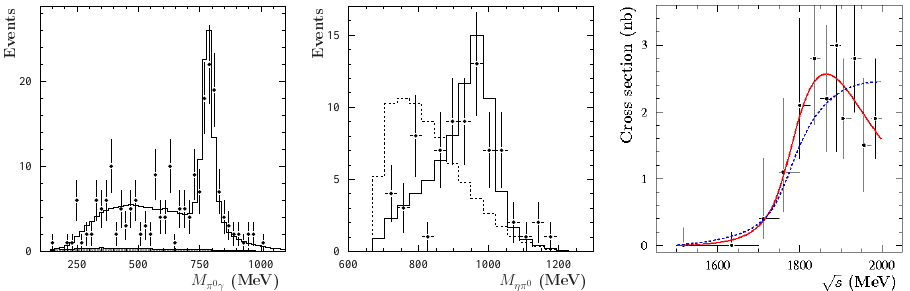
Figure 6. Left panel : The π 0 γ invariant mass spectrum which shows the dominance of the ωπ 0 η intermediate state. Middle panel : The ηπ 0 invariant mass spectrum for selected e + e − → ωηπ 0 events. The solid histogram represents e + e − → ω a 0 (980) simulation, while the dashed histogram represents the ωηπ 0 phase-space simulation. Right panel : The e + e − → ωηπ 0 cross section measured by SND. The solid (dashed) curve shows the result of the fit with (without) a resonance